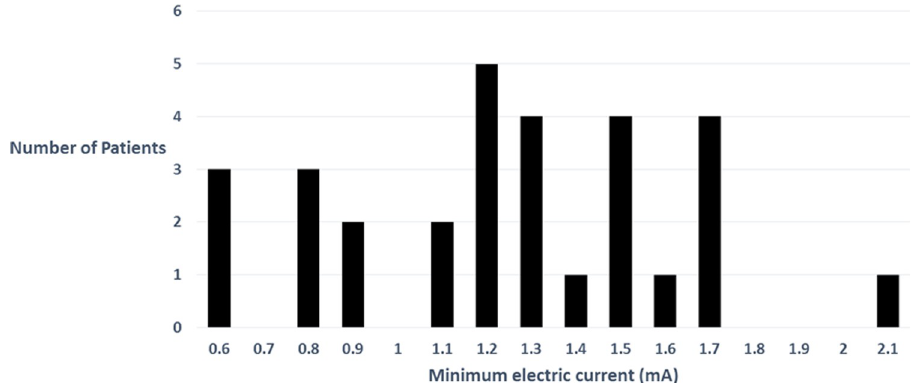
Fig 2. Minimum electric current for evoking paresthesia or muscle contraction in the electric stimulation group (n = 30). For confirming epidural catheter placement the minimum current required was 0.6–2.1 mA and the median [interquartile range] current was 1.25 [0.9–1.5] mA (frequency: 1 Hz; pulse-width: 300 ms).